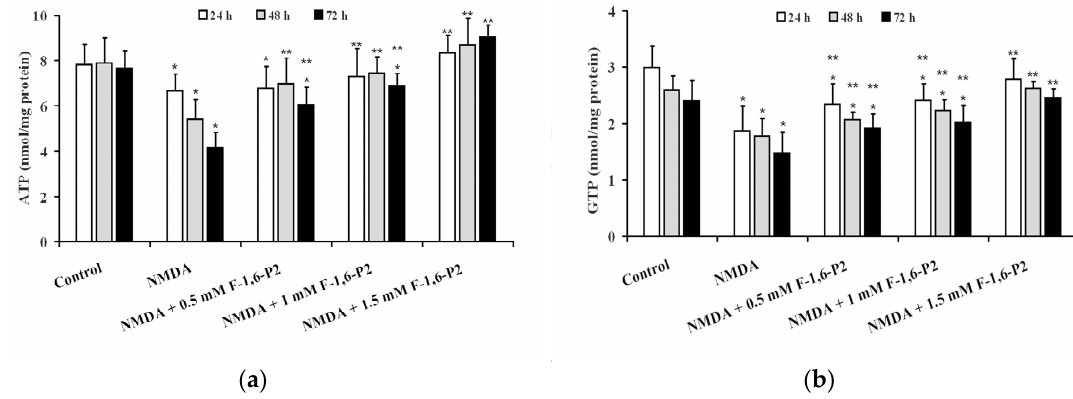
Figure 2. Effects of F-1,6-P2 on the recovery of high energy phosphate concentrations in NMDA-treated OHSC. OHSC were challenged with 30 μ M NMDA for 3 h and then incubated without and with increasing concentrations of F-1,6-P2 (0.5, 1 and 1.5 mM) for different times (24, 48 and 72 h). Control OHSC were incubated for the same time intervals, with no prior NMDA treatment or F-1,6-P2 addition. ATP ( a ) and GTP ( b ) were determined by HPLC in deproteinized cell extracts. Histograms are the mean of 6 different OHSC preparations. Standard deviations are represented by vertical bars. * Significantly different from corresponding time of control OHSC, p < 0.001. ** Significantly different from corresponding time of NMDA-challenged OHSC with no F-1,6-P2 supplementation, p < 0.001.